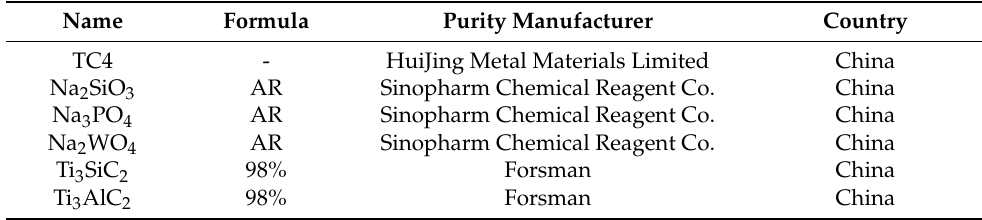
Table 1. Experimental reagents and